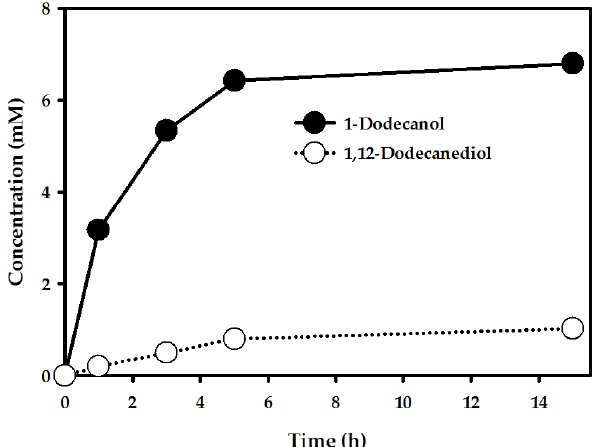
Figure 4. In vivo production of α , ω‐ diols by one ‐ pot, one ‐ step reaction using two different type of E. coli BW25113 ( ∆ fadD, DE3) cells coexpressing MaqCYP153A33 with CamAB and MmCAR ‐